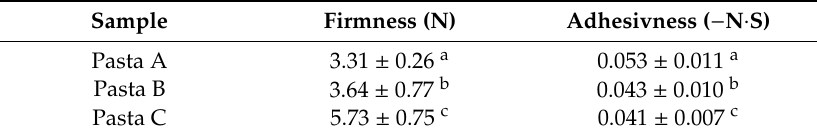
Table 5. Texture characteristics of the three types of pasta after